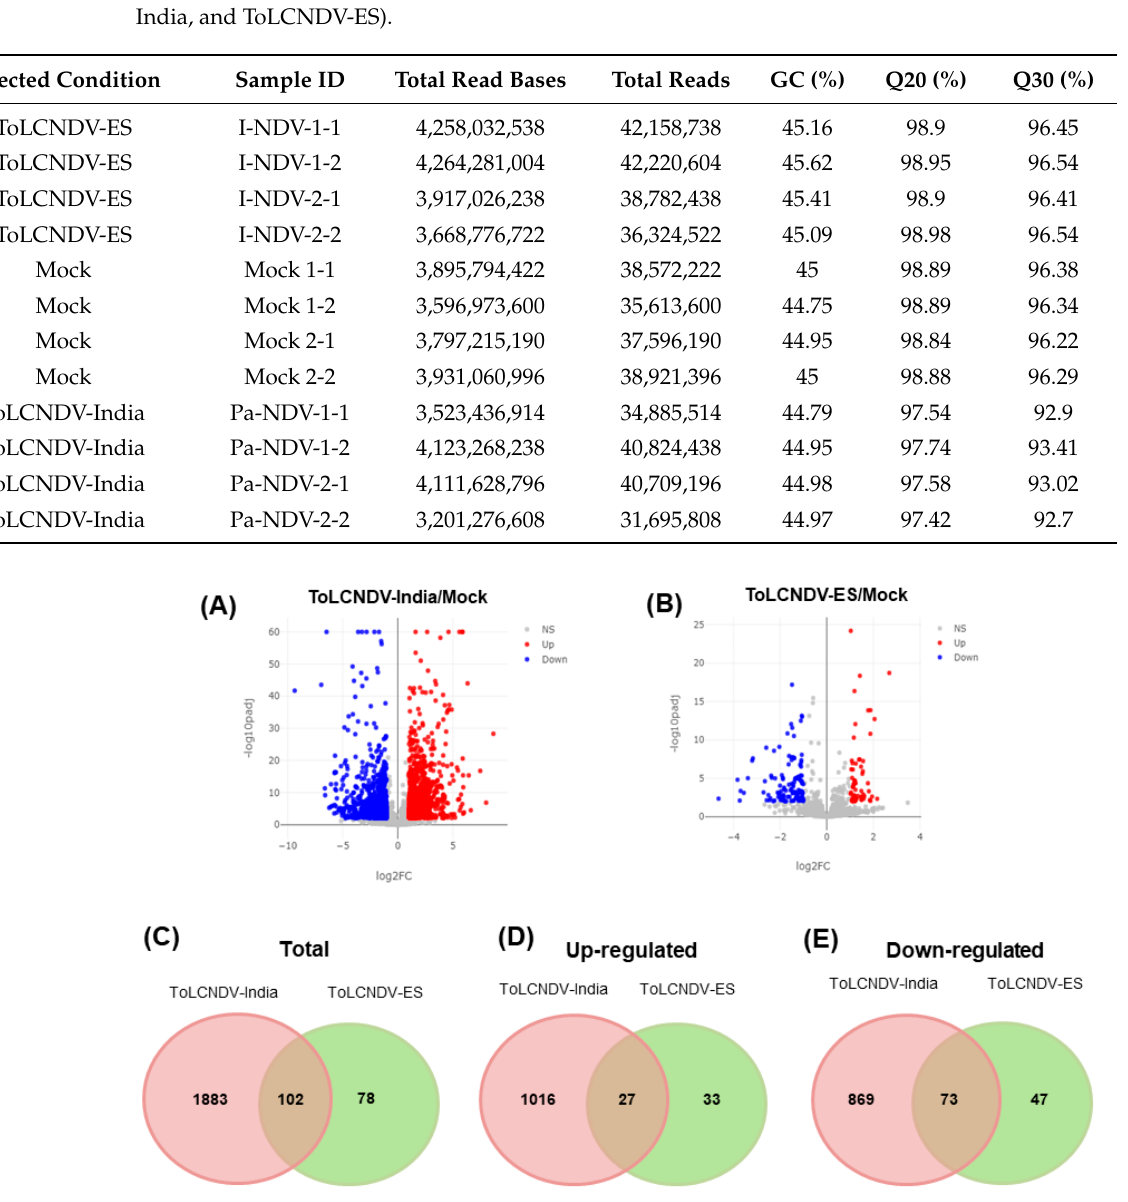
Figure 5. Identification of DEGs under each ToLCNDV isolate infection. Volcano plots were con- structed with DEGs under ( A ) ToLCNDV-India and ( B ) ToLCNDV-ES infection. ( C – E ) Venn diagram representing the number of DEGs in total and the separately upregulated and downregulated genes, respectively.